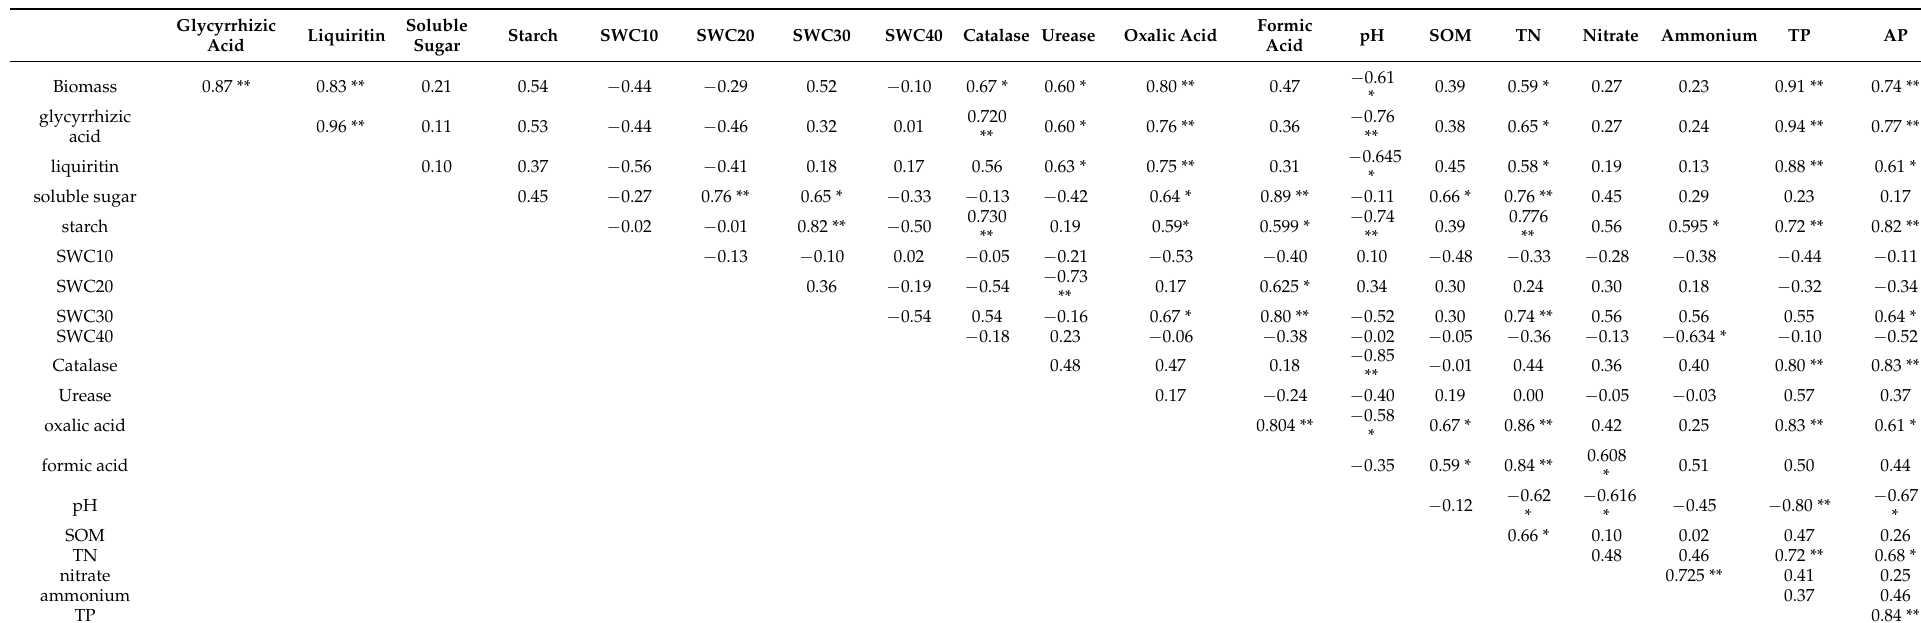
Table 1. Correlations between biomass, soil properties, and licorice quality